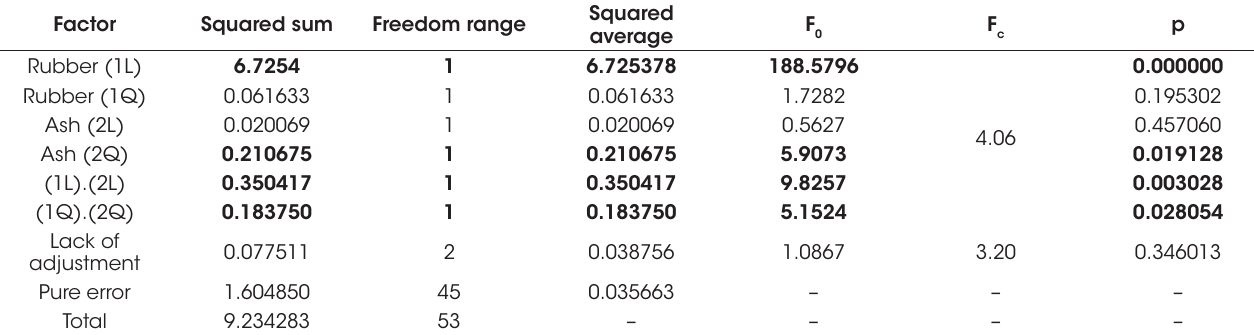
Analysis of variance on compressive strength of mortars